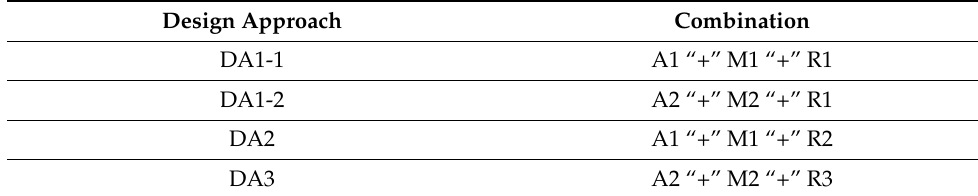
Figure 3. Design approaches in EU countries for pile foundations (modified from [8]). Table 4. Design approaches and